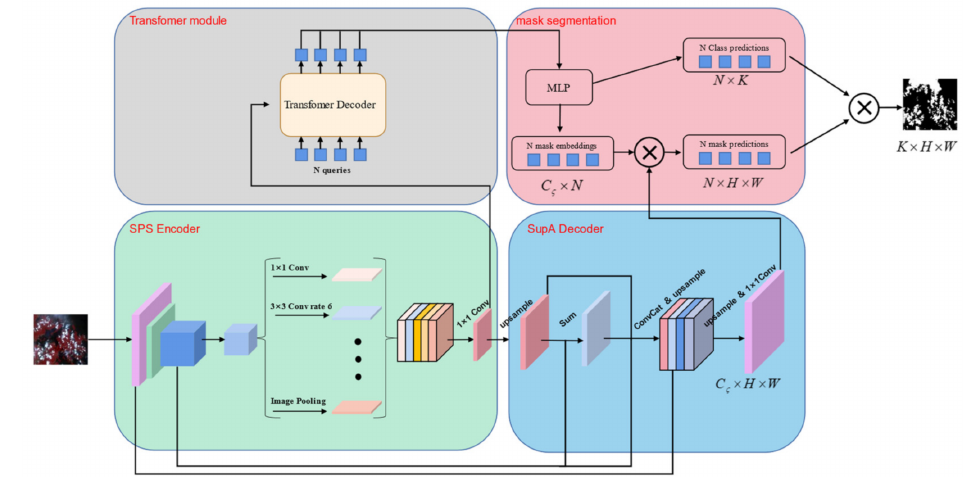
Figure 1. There are four key components in the framework: SPS Encoder, SupA Decoder, Transformer module, and mask segmentation. The remote-sensing data are input into the SPS encoder to extract the feature of the cloud through convolution. Then the feature is sent to the SupA decoder for pixel-level decoding. The feature will also be sent to the Transformer module to use the attention mechanism for further calculations to obtain mask information and classification embeddings of information. Finally, the two parts of information are combined in the mask segmentation to obtain the prediction